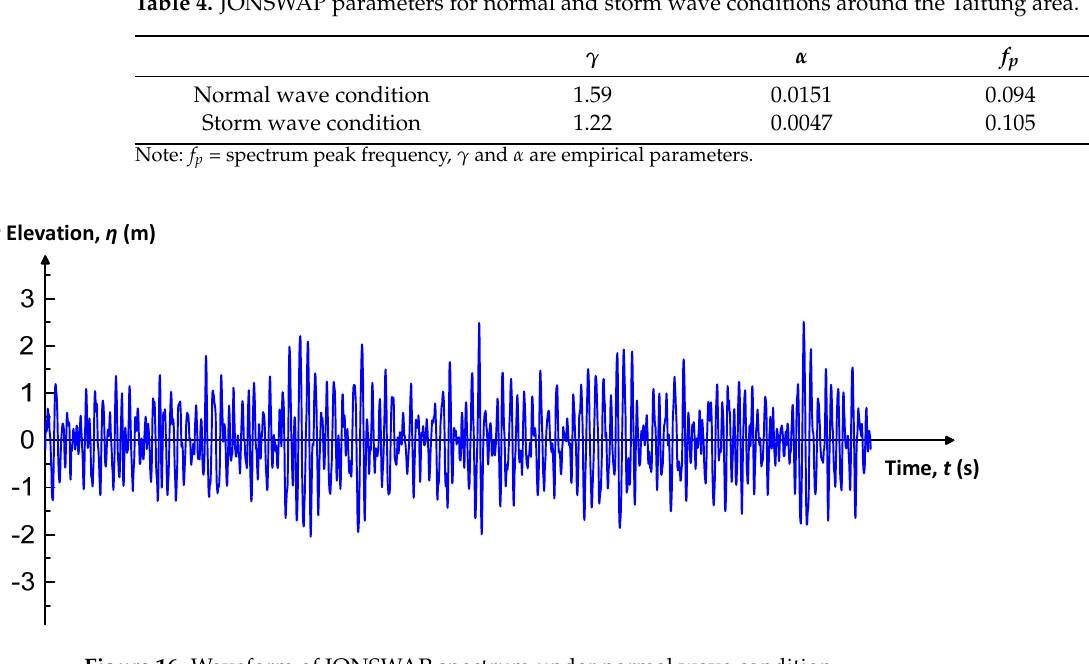
Figure 15. ( a ) Experimental result for the neutral position of the duct by different attack angle of the wings [16]; ( b ) sub- merged depth with different design weight of the duct.